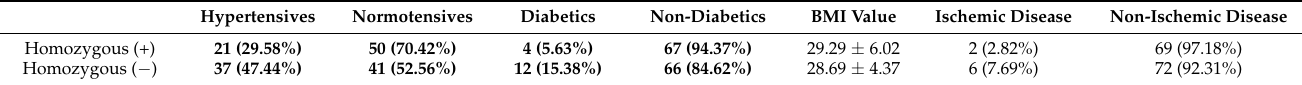
Table 6. The prevalence of the disorders in patients with the rs2736100 SNP of the TERT gene, taking into account the presence of homozygotes. Statistically significant differences are indicated by boldface ( p <